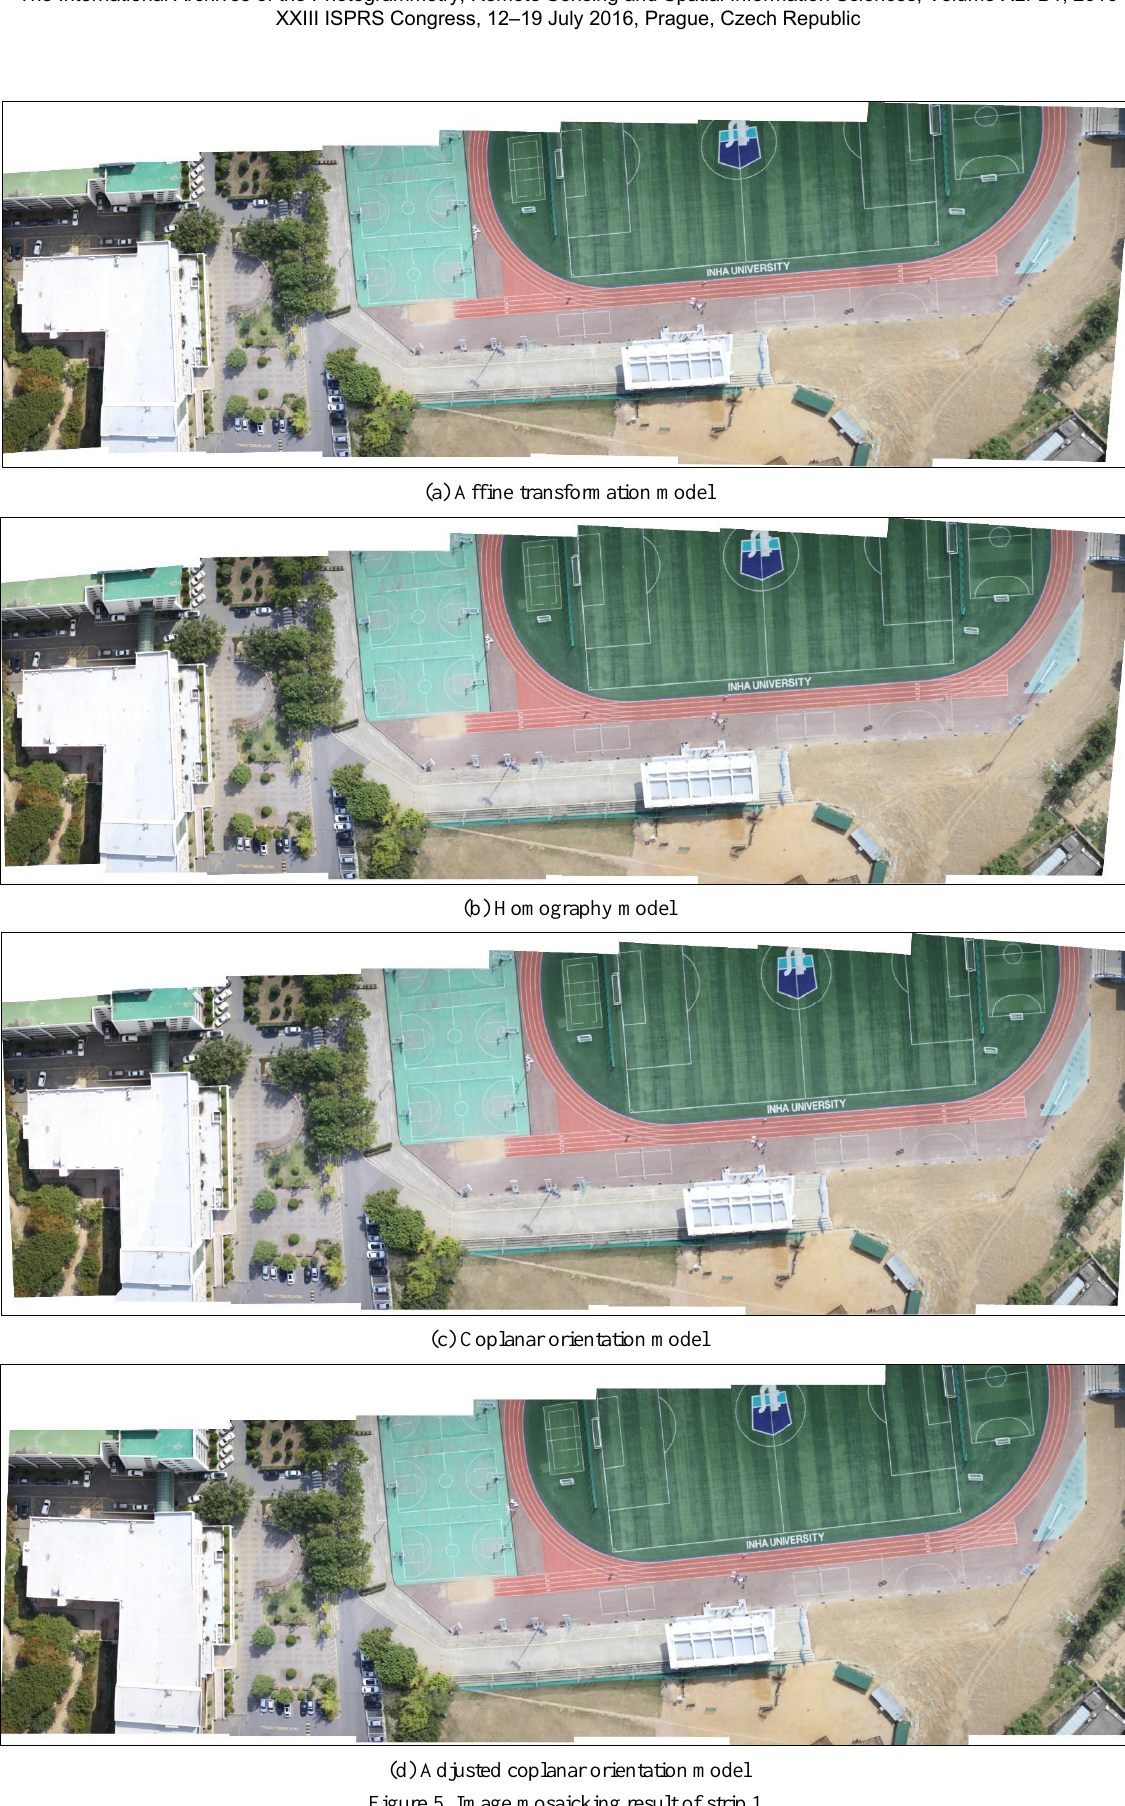
Figure 5. Image mosaicking result of strip